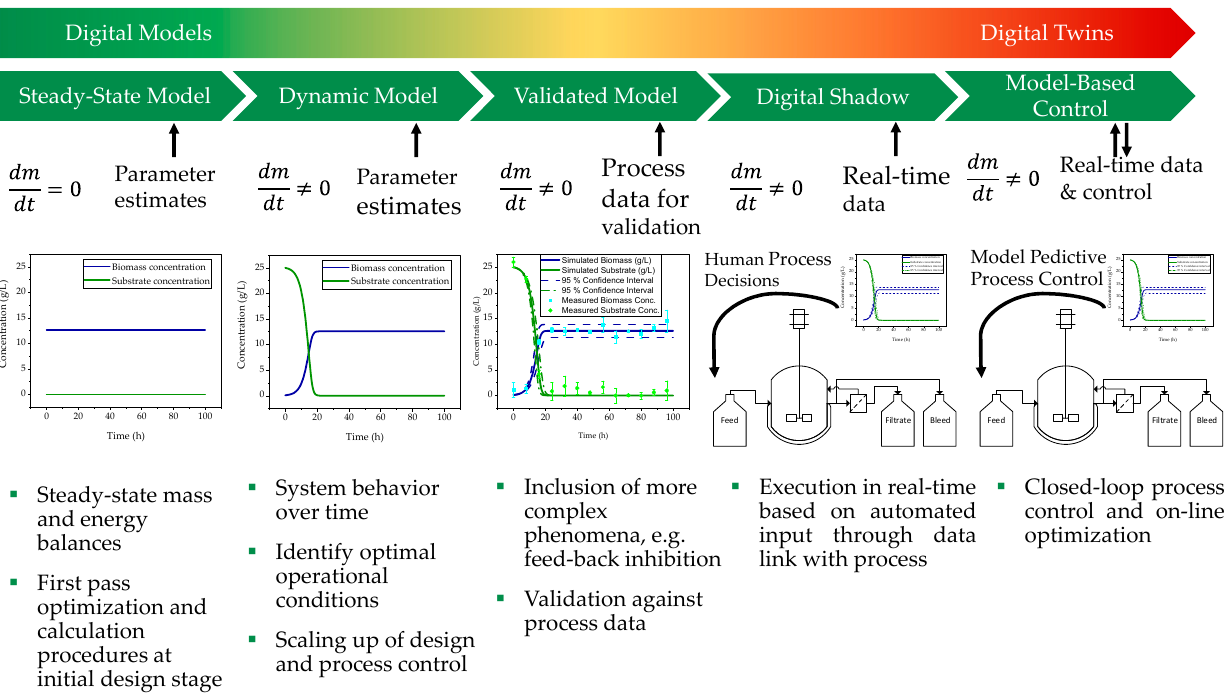
3 of 15 Figure 1. Workflow of model validation based on a QbD-oriented approach [37]. In a first step, the QTPPs are defined. Subsequently, the CQAs are defined and a risk assessment of the influence of various process parameters on the CQAs is carried out. The risk assessment results in a design space for the process parameters to be investigated, which can be examined either via experiments or by means of a rigorous process model. Based on the results, a control strategy is defined, which can be continuously compared online via PAT with the actual state of the system. Strict implementation of this strategy allows for continuous process optimization. In analogy to the experimental development, design-of-experiments (DoE) can also be used in the model validation. This allows the evaluation of the criticality of the inves- tigated parameters, and additionally the definition of a design space [38]. The following steps in QbD-based process development deal with the feasibility of a control strategy [39]. The control strategy lists the critical process parameters and the CQAs depending on them, which have to be measured continuously in order to achieve QTTP assurance. Key enabling technologies for continuous monitoring are grouped un- der the umbrella term process-analytical-technology (PAT). Real time release testing (RTRT) could be realized based on full QbD-based process development and validated PAT, eliminating bottlenecks in the production of critical biopharmaceuticals [40]. The continuous monitoring of process variables by PAT as well as the achieved and docu- mented process understanding allow the process to be continuously improved based on new process data [41]. 1.2. Model Validation The feasibility of the continuous monitoring, control, and optimization of the process